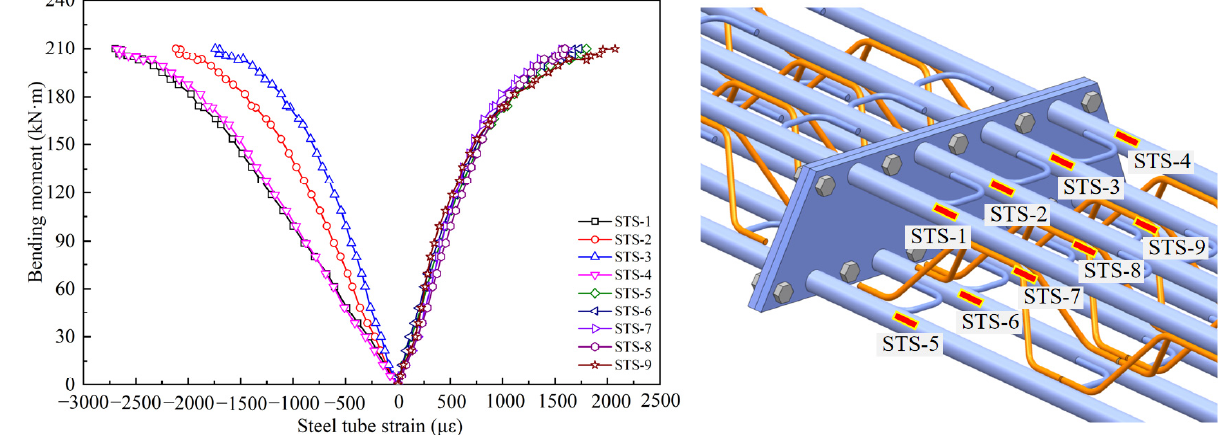
Figure 14. Bending moment–steel tube strain curves of the end-plate joint component.